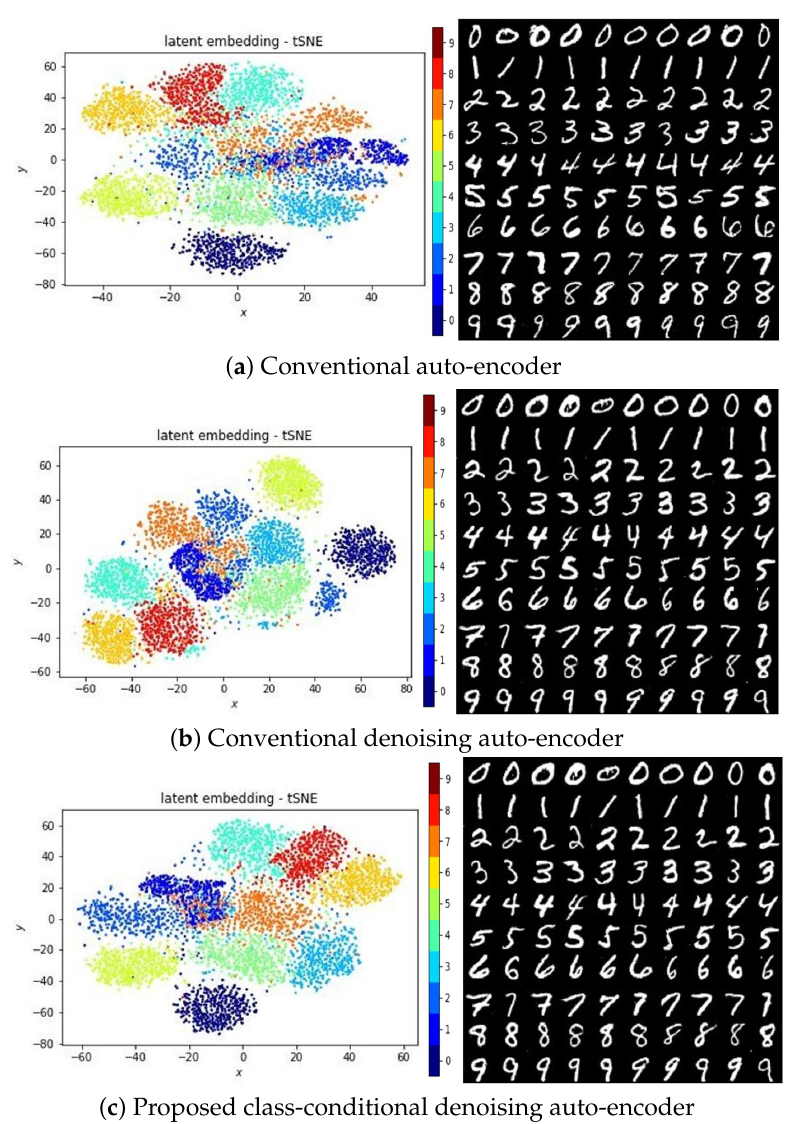
Figure 3. Difficulty in conventional autoencoder